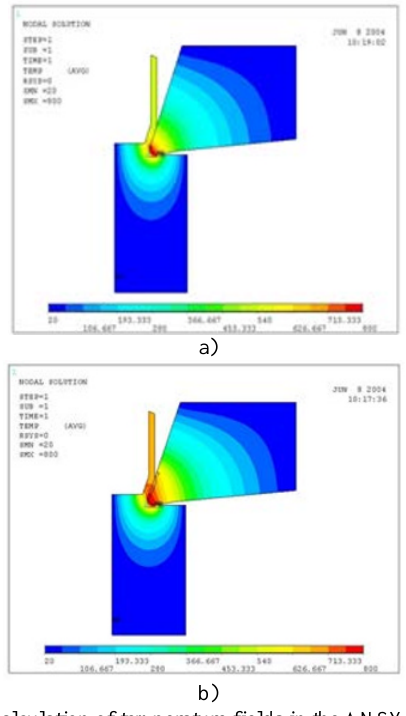
Fig. 4. Calculation of temperature fields in the ANSYS environment: λ = 0.25 (a); λ = 0.15